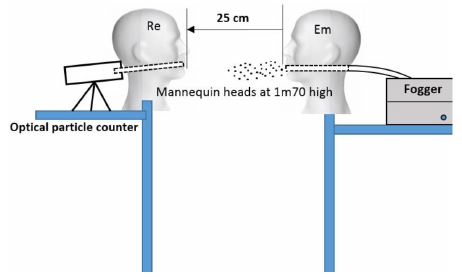
Figure 1. Experimental setup; Em: emitter; Re: